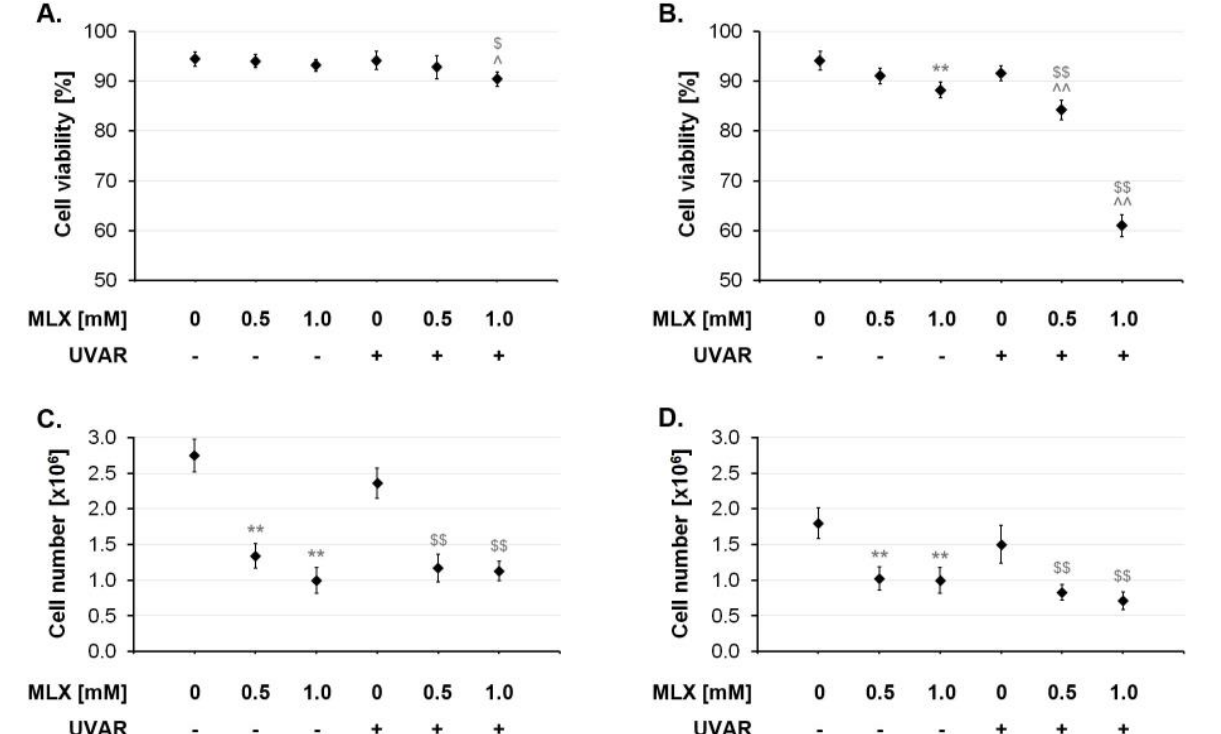
Figure 2. The influence of MLX and/or UVAR on fibroblasts ( A , C ) and melanocytes ( B , D ) viability and cell number. The cells were pretreated with MLX at concentrations 0.5 mM and 1 mM and then exposed to UVAR. ** p < 0.01 vs. untreated cells (control), $ p < 0.05 vs. irradiated cells (not treated with meloxicam), $$ p < 0.01 vs. irradiated cells (not treated with meloxicam), ^ p < 0.05 vs. corresponding sample not treated with UVAR, ^^ p < 0.01 vs. corresponding sample not treated with UVAR.